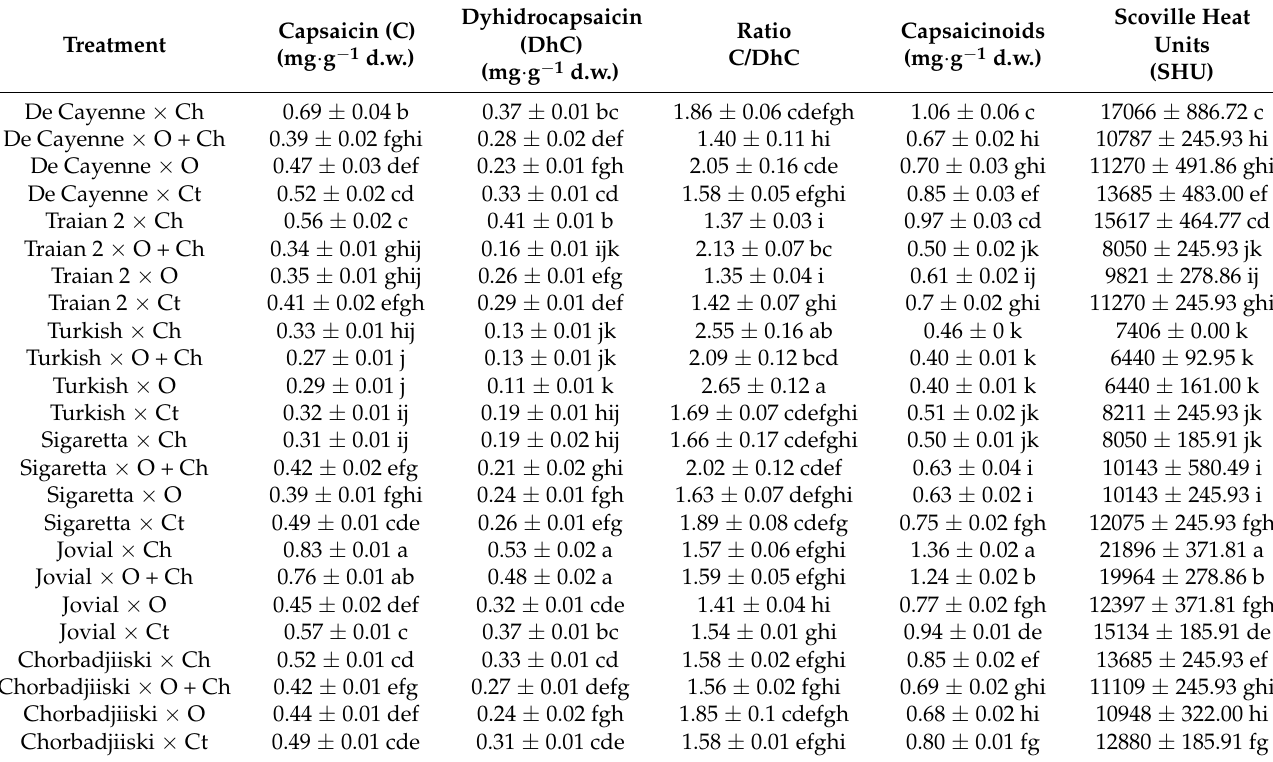
Table 5. Interaction between cultivar and fertilization on capsaicinoid content and Scoville scale.